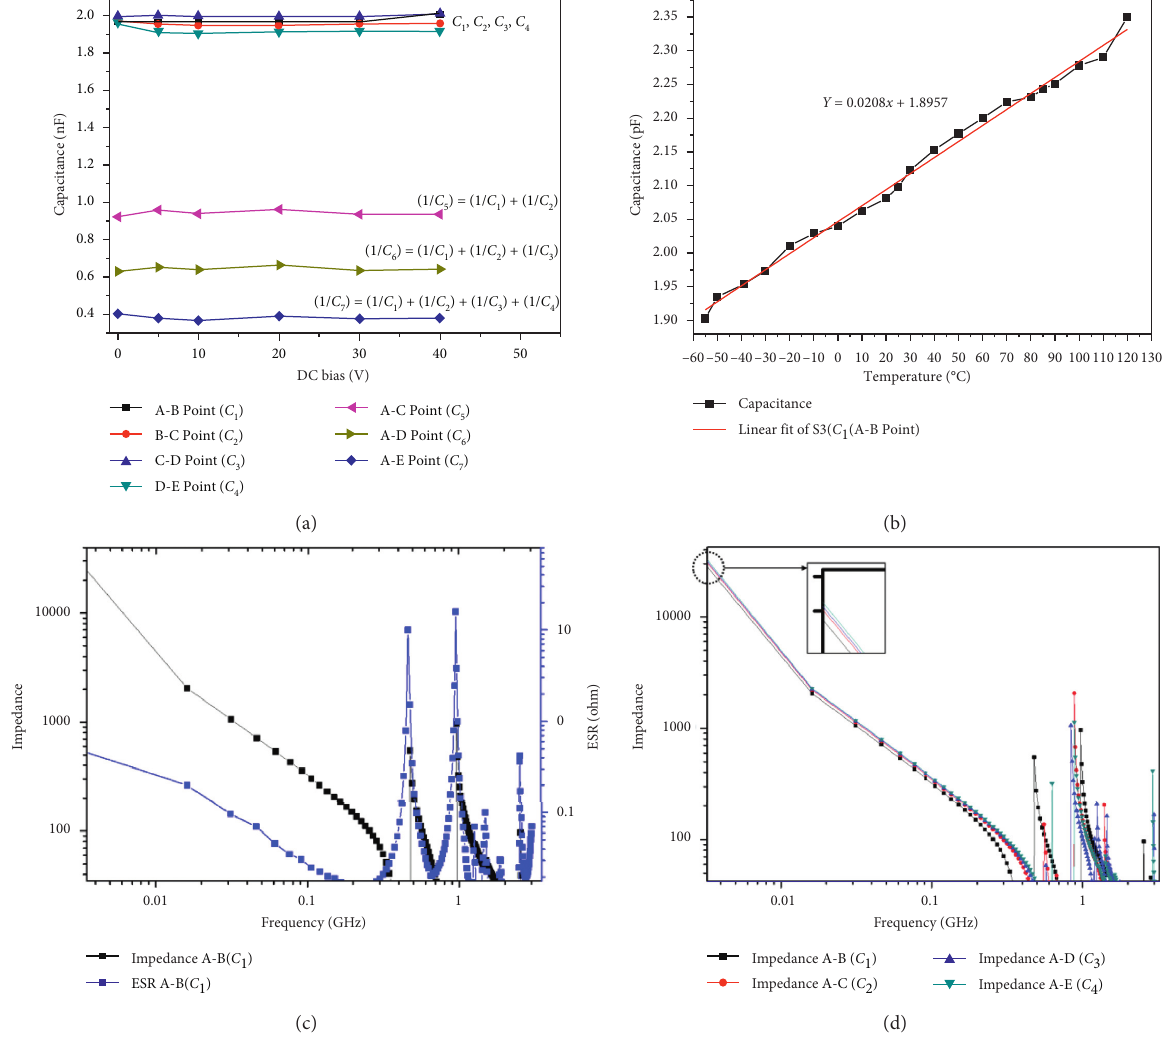
Figure 6: Electrical properties according to frequency. (a) Capacitance vs DC bias. (b) Capacitance vs temperature. (c) Impedance/ESR vs frequency @ C 1. (d) Impedance vs frequency @ C 1, C 2 , C 3 , C 4